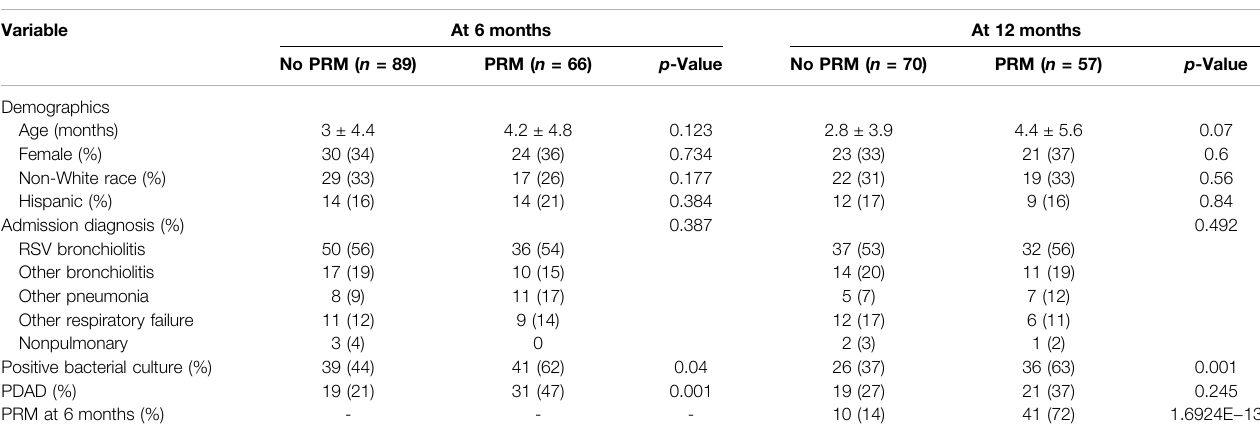
TABLE 1 | Demographics and clinical characteristics of the study group at 6 and 12 months.